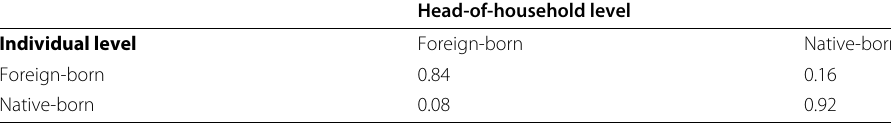
Table 6 Comparison table between individual and head-of-household variable nativity status Individual